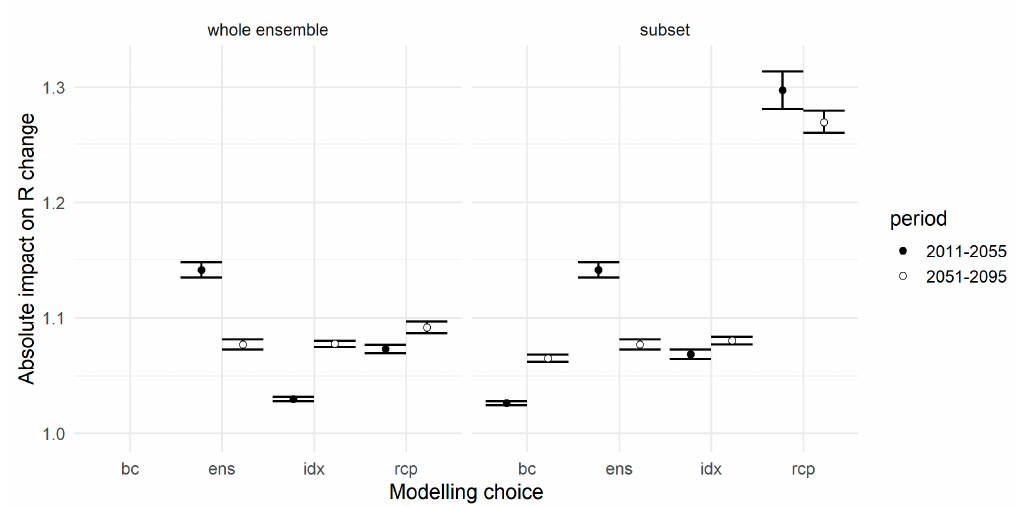
Figure 8. Effect of modelling decisions on future R changes relative to the R changes estimated with the bias-corrected subset for RCP 4.5 and Equation (1) (R change relative to 2001-15, cf. Figure 6), alternative choices of bias correction (bc), ensemble (ens), RCP (rcp), and index (idx, mean of Equations (2) and (3)). Mean and confidence interval (p = 95%) of climate stations and four overlapping 15-year periods. Values in left-most column outside value range (2011–2055: 1.98 ± 1.02, 2051–2095: 41 ± 75).